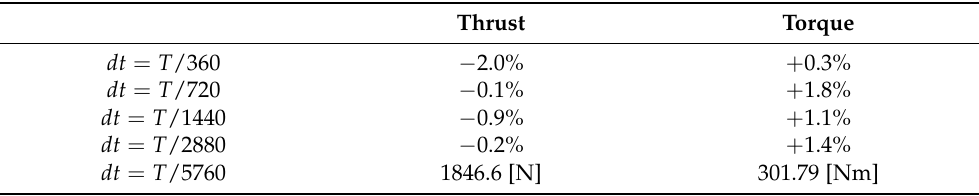
Table 4. Thrust (N) and Torque (Nm) estimation with respect to different time-step values. Reference values correspond to the finest time-step value